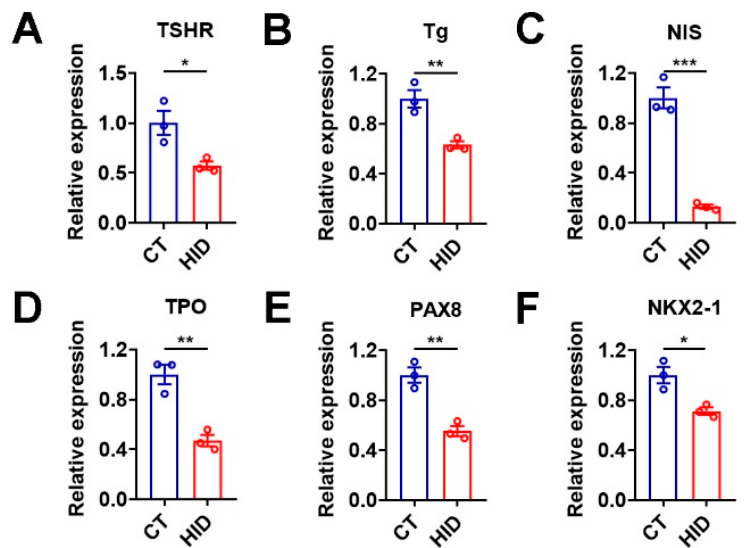
Figure 1. Excessive iodide intake downregulates the mRNA expression of genes involved in thyroid hormone (TH) synthesis in mouse thyroid. ( A – F ) Relative mRNA levels of genes involved in TH synthesis, including TSHR ( A ), Tg ( B ), NIS ( C ), TPO ( D ), PAX8 ( E ), and NKX2-1 ( F ), in the thyroid of C57 mice after exposure to excess iodide. Individual data points represent pooled samples, each containing thyroids pooled from three mice in each group. HID, high-iodide diet group; CT, control group. Data are presented as mean ± SEM. Statistical significance was determined by Student’s t -test; * p < 0.05, ** p < 0.01, and *** p < 0.001.